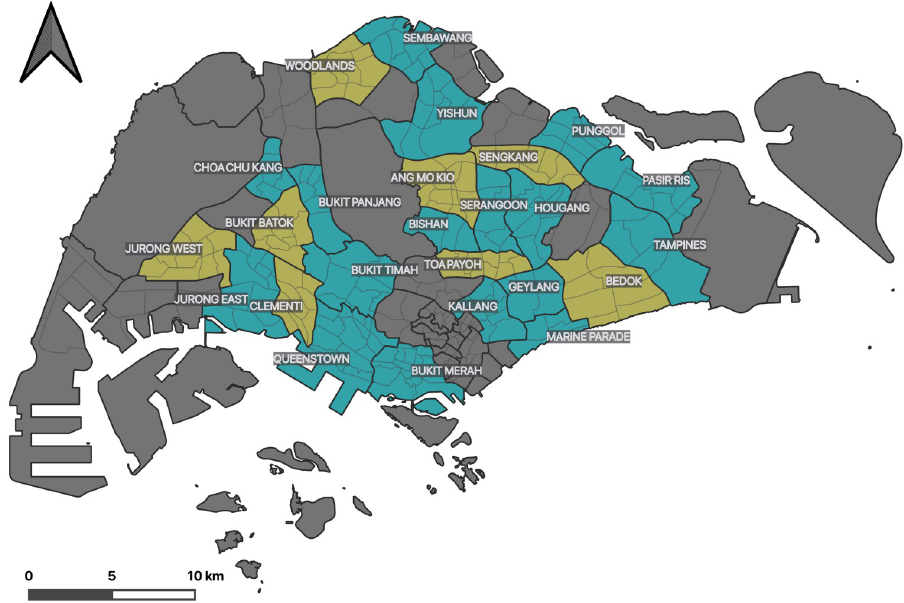
Fig 2. Planning areas (thick lines) including their subzones (thin lines) in Singapore. The yellow areas are part of the training group, while the turquoise zones are the test areas for estimations. The grey parts of the country are out of scope of our work because they are not residential or not dominated by HDB. Source of the administrative dataset: Urban Redevelopment Authority / data.gov.sg